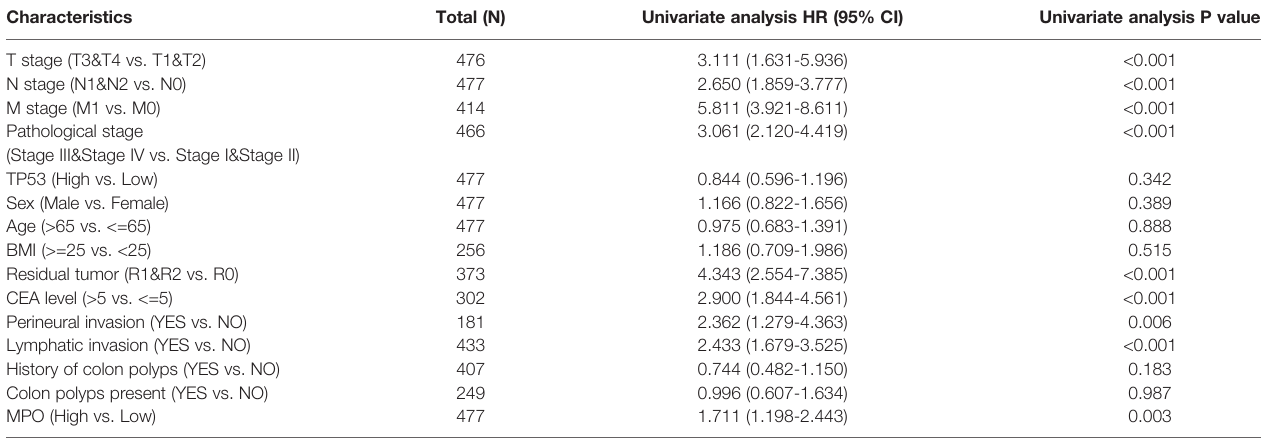
TABLE 5 | Univariate analysis of prognostic factors for PFI with the Cox regression